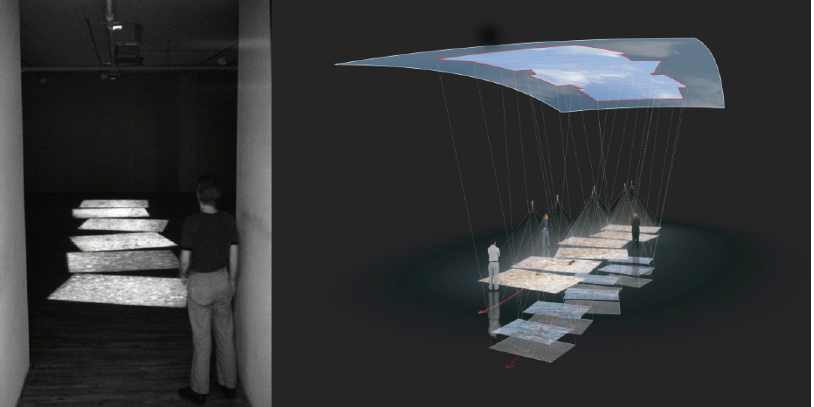
Figure 1a, b: “Migration” film installation created in 1978; rendering deconstructing the installation’s